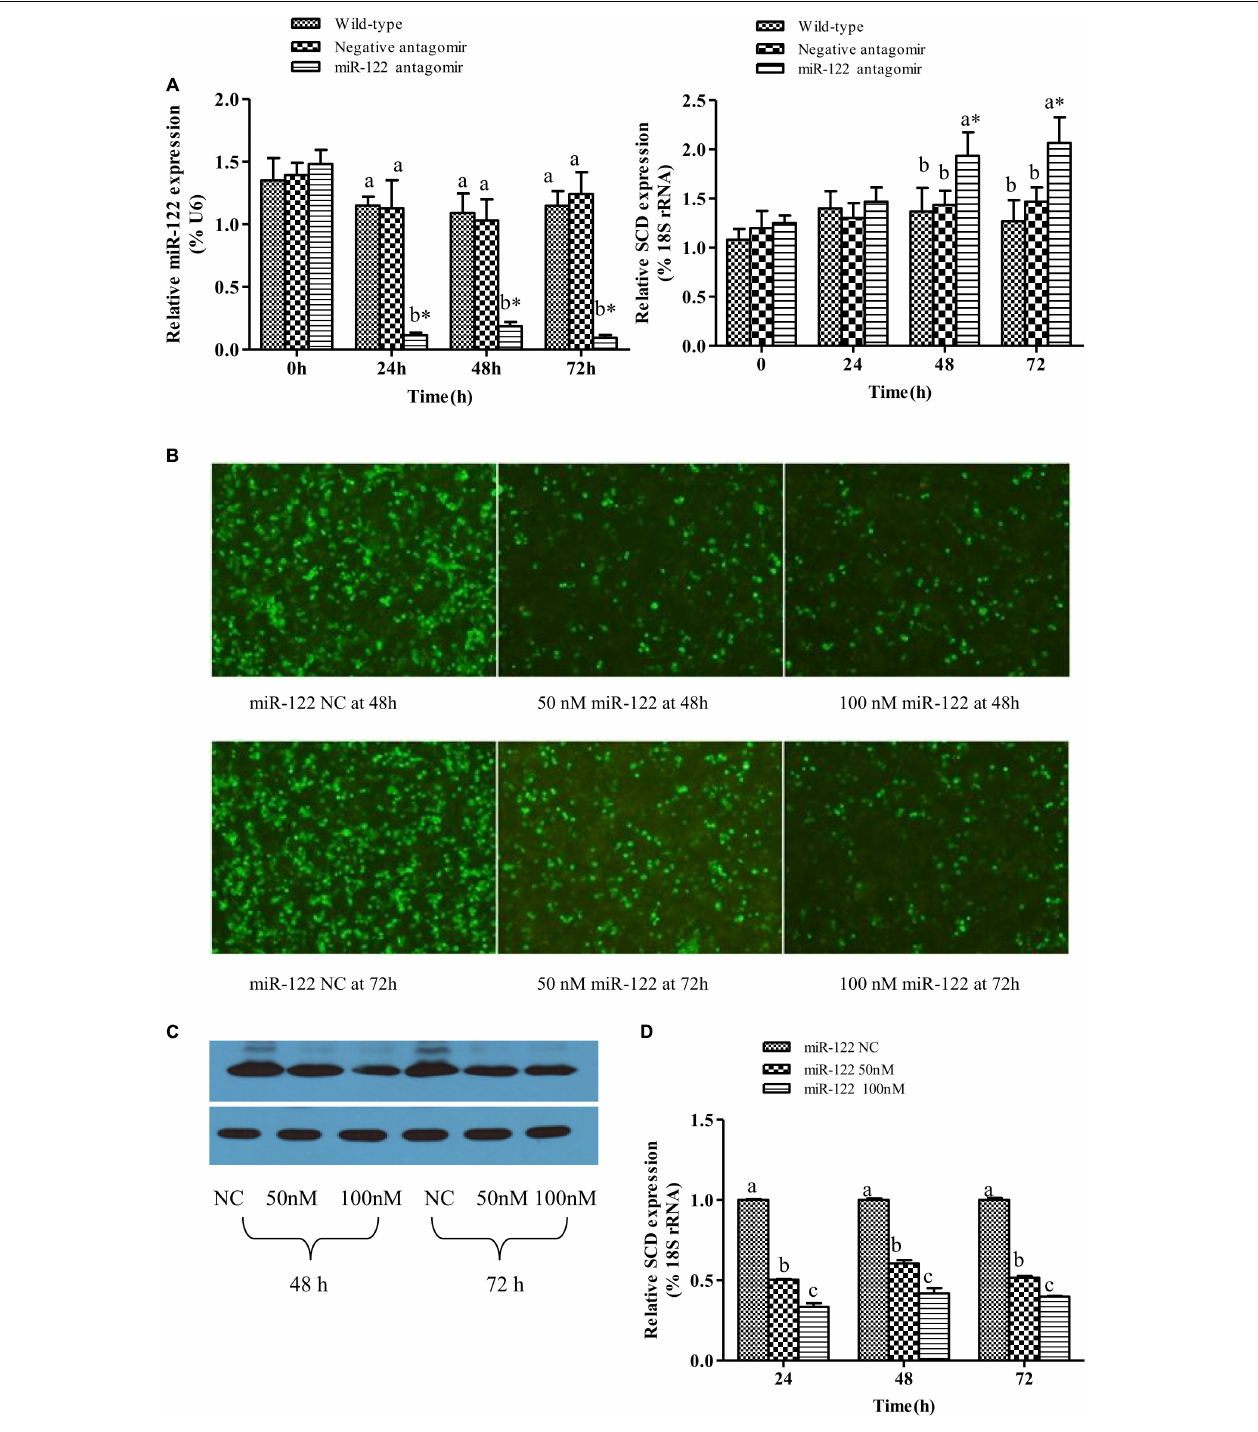
FIGURE 2 | Analysis of regulatory relationships between miR-122 and SCD . (A) Juvenile GIFT weighing about 10 g were injected in tail vein with PBS, miR-122 negative control, or miR-122 antagomir (dose, 50 mg kg - 1 body weight). Transcript levels of SCD and miR-122 in GIFT liver were determined by qRT-PCR for 72 h. GIFT injected with PBS served as control. (B) Verification of regulatory relationship between miR-122 and SCD at hepatocyte level. pEGFP-C1-3Flag-SCD-3 (cid:48) -UTR and 50 nM or 100 nM miR-122 mimic or same dose of miR-122 negative control was co-transfected into hepatocytes by lipofectamine 2000. (C) Protein expressions of SCD at hepatocyte level as determined by western blotting. (D) Transcript levels of SCD at hepatocyte level as determined by qRT-PCR. ∗ P < 0.05 indicates significant differences between values obtained before and after injection or transfection (paired-samples t test). Different lowercase letters show significant differences among treatments at each sampling point ( P < 0.05, Duncan’s multiple range test).